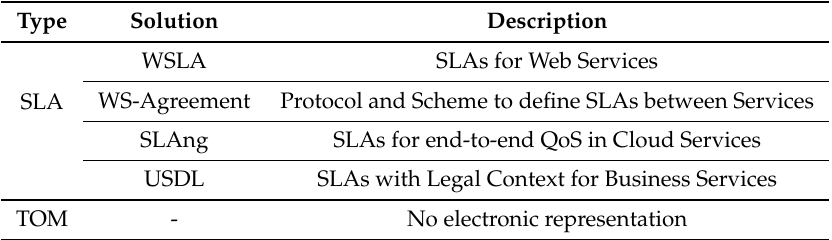
Table 7. Overview of languages and their description to define SLAs and TOMs.